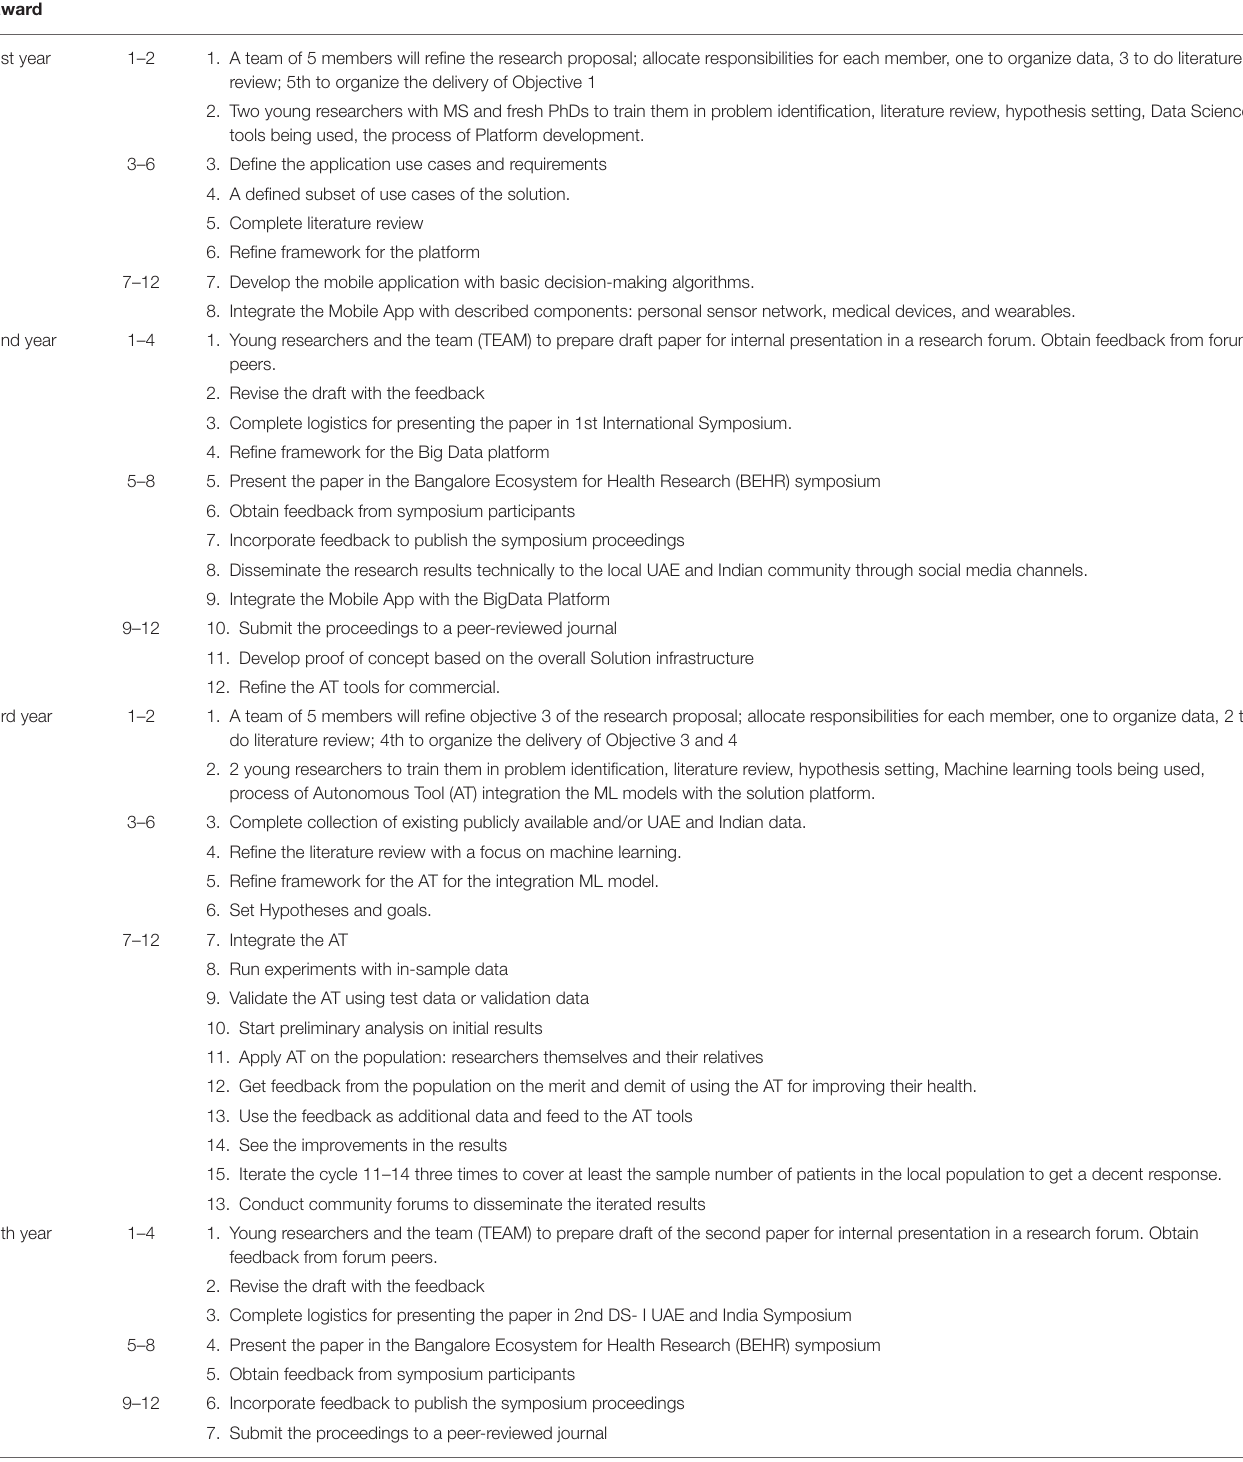
TABLE 3 | Proposed project yearly plan. Year of